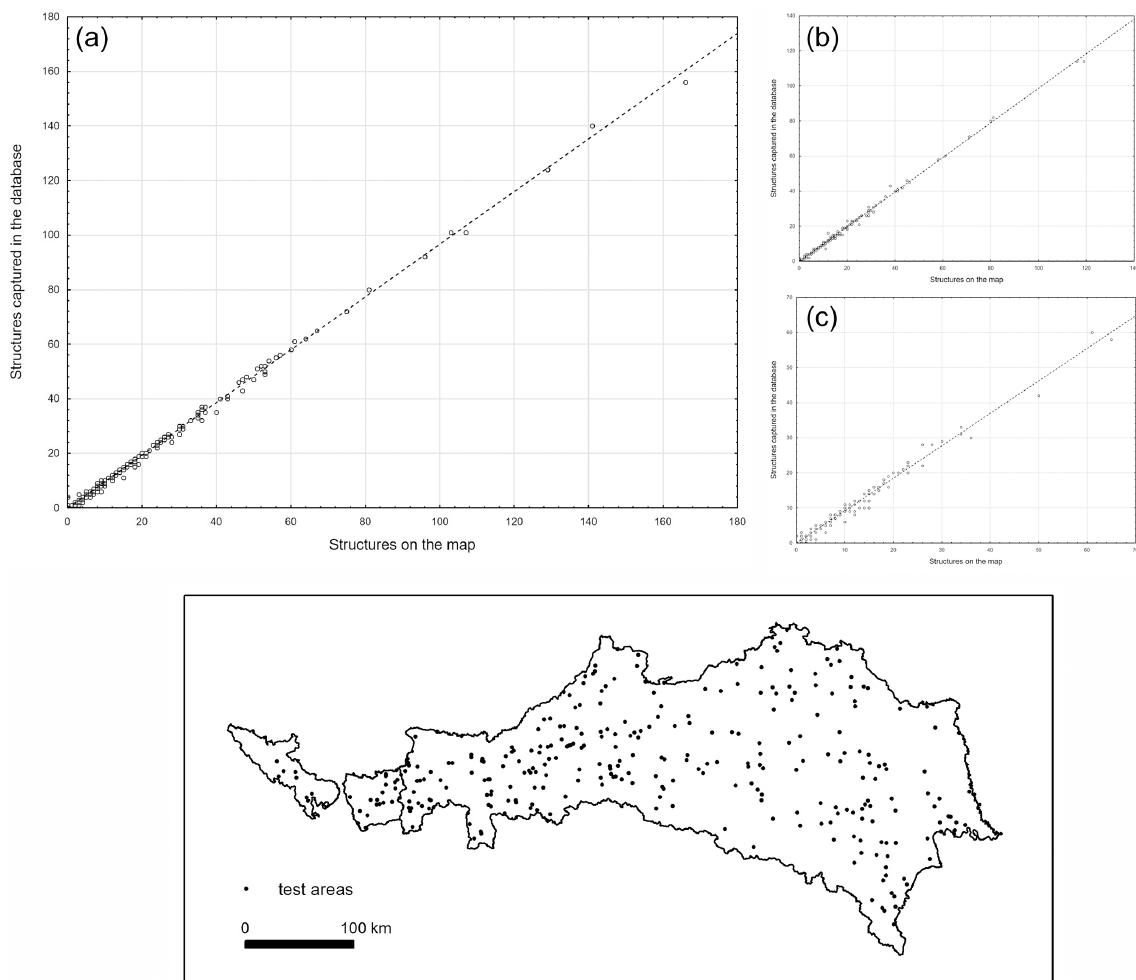
Figure 5. Pearson’s correlations r between the number of buildings shown on the maps and the number of structures acquired in the dataset for all buildings (a) , residential buildings (b) , and farm-related buildings (c) , n = 311. The lower panel is the location of the test